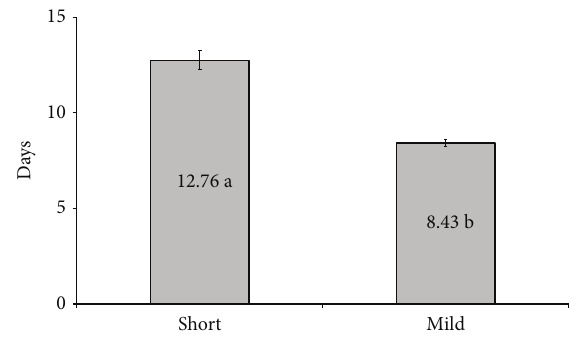
Figure 2: Number of days of stimulation. Means followed by different letters differ significantly through the 𝑡 -test at a 5% probability.